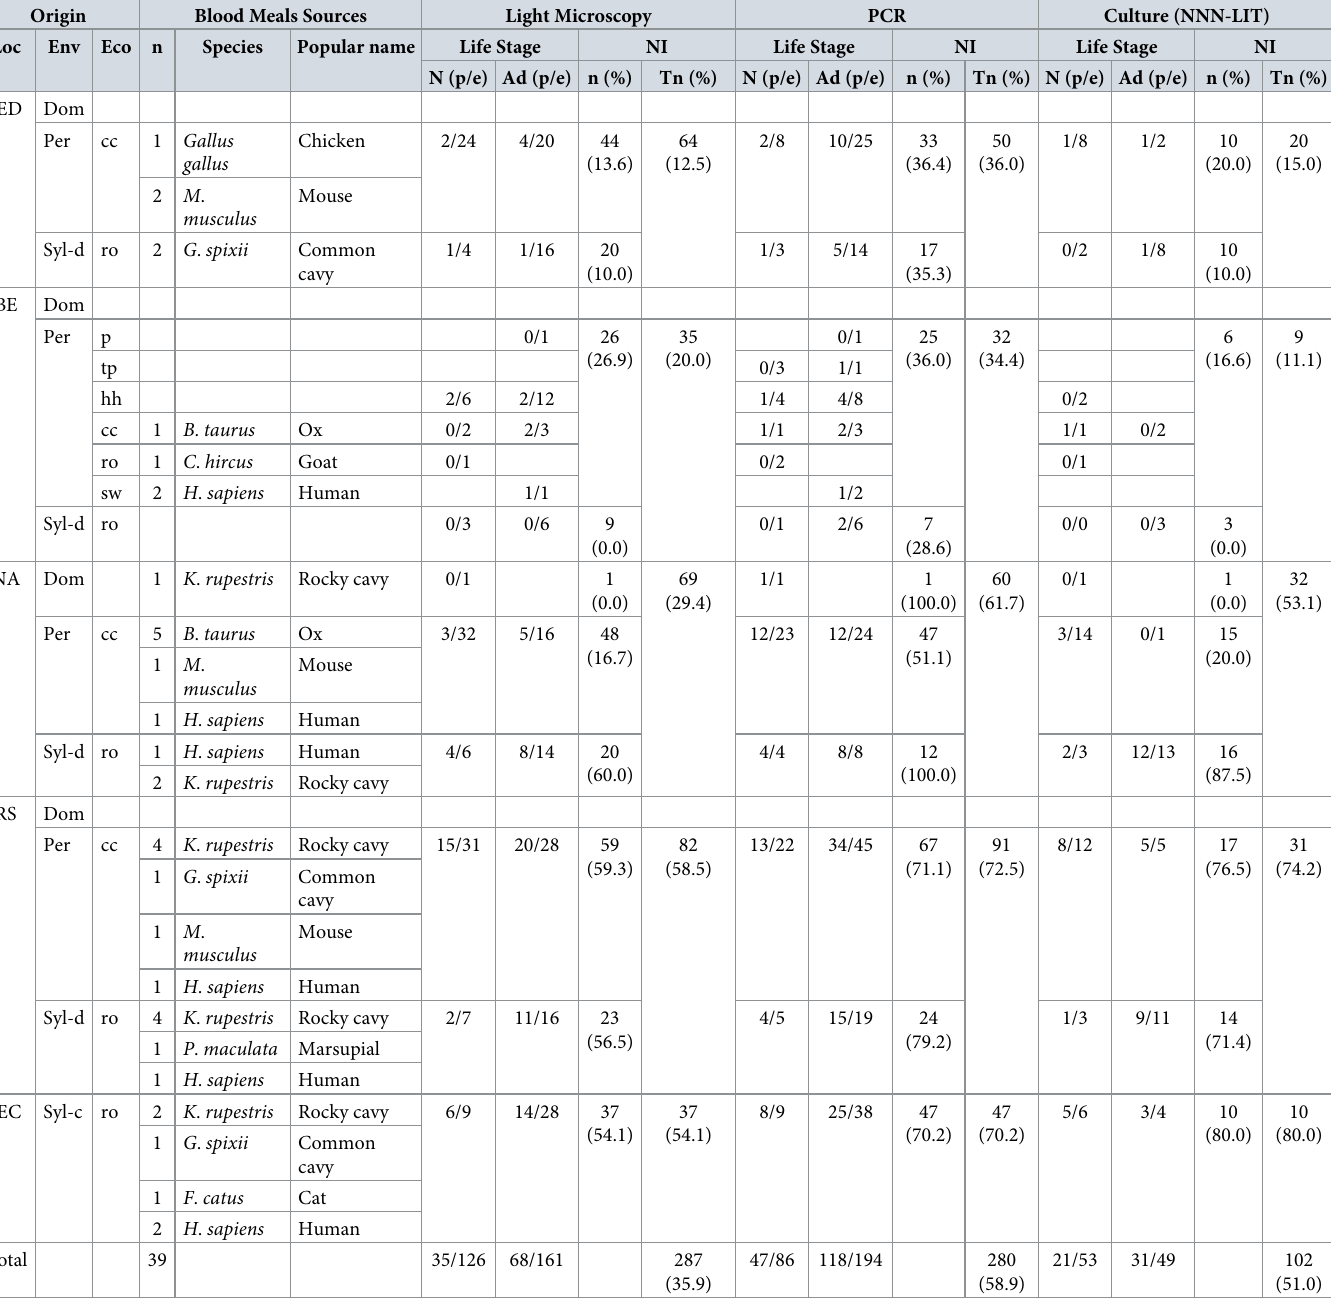
Table 3. Origin, blood meals sources and natural infection by T . cruzi ; using Light Microscopy, PCR and Culture; of Triatoma b . brasiliensis captured in peridomes- tic and sylvatic environments of the localities in the Caico´ municipality, Rio Grande do Norte,